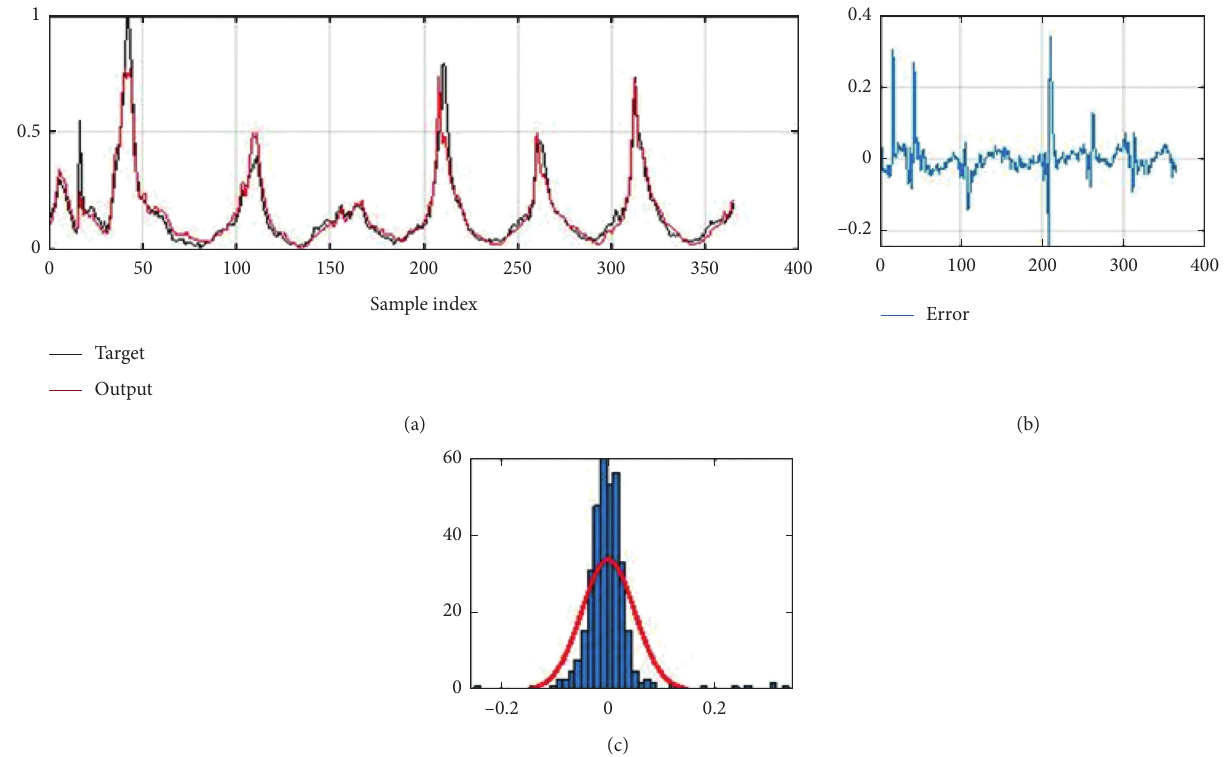
Figure 8: Performance of the ANNPSO model. (a) Train data. (b) MSE � 0.0024304, RMSE � 0.049299, and MAE � 0.2594. (c) Error St. D. � 0.049355.